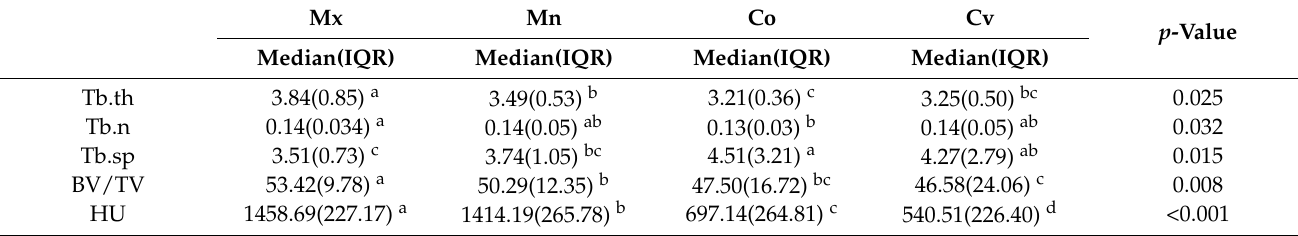
Table 5. Comparison of the bone mineral density parameters among